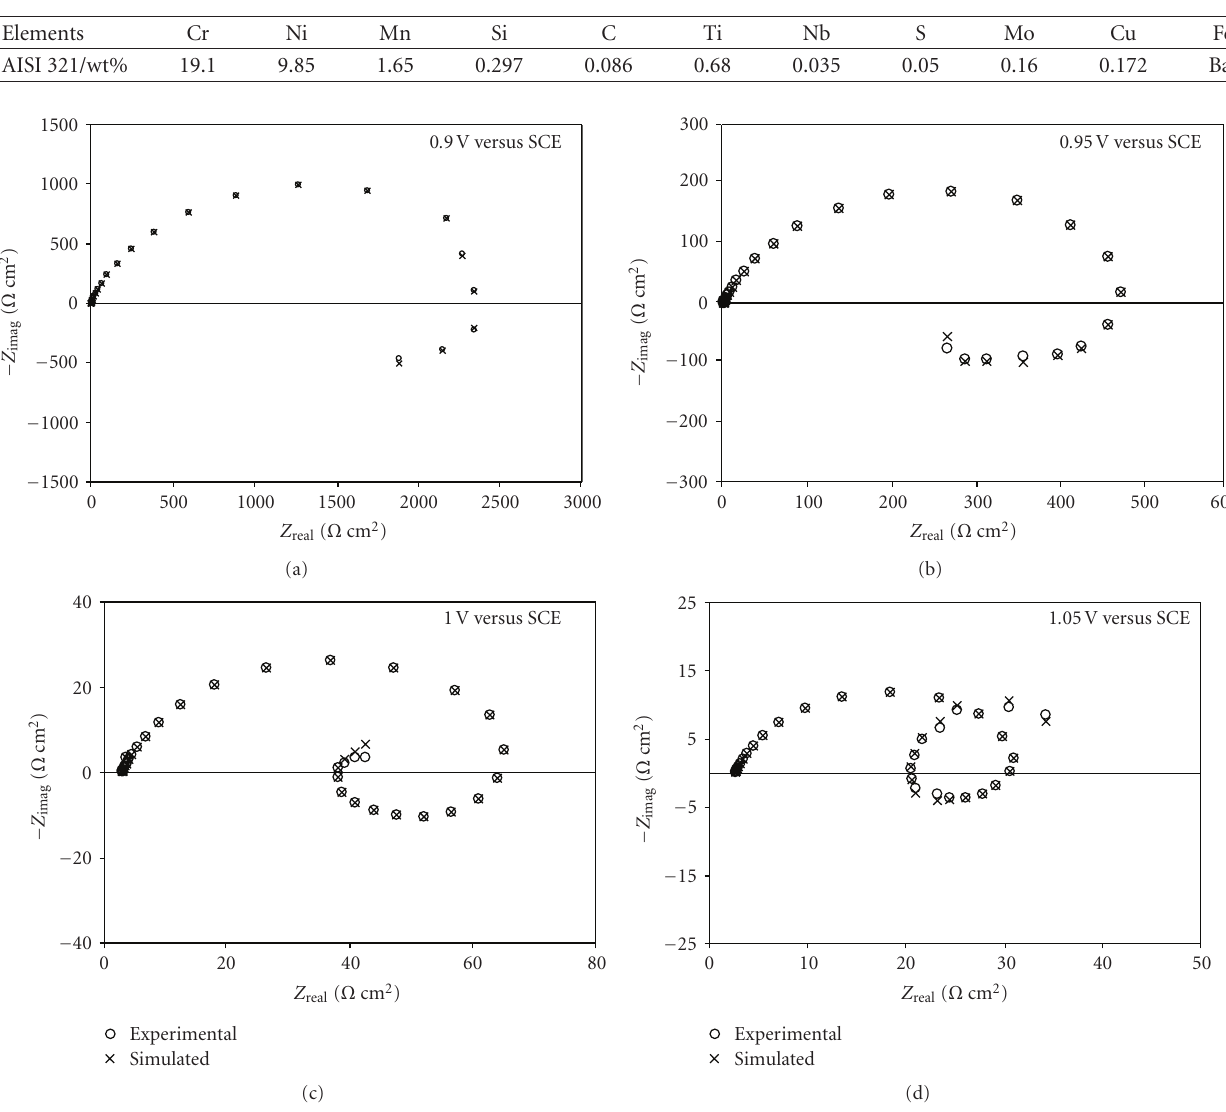
Table 1: Nominal chemical composition of AISI 321 stainless steel.